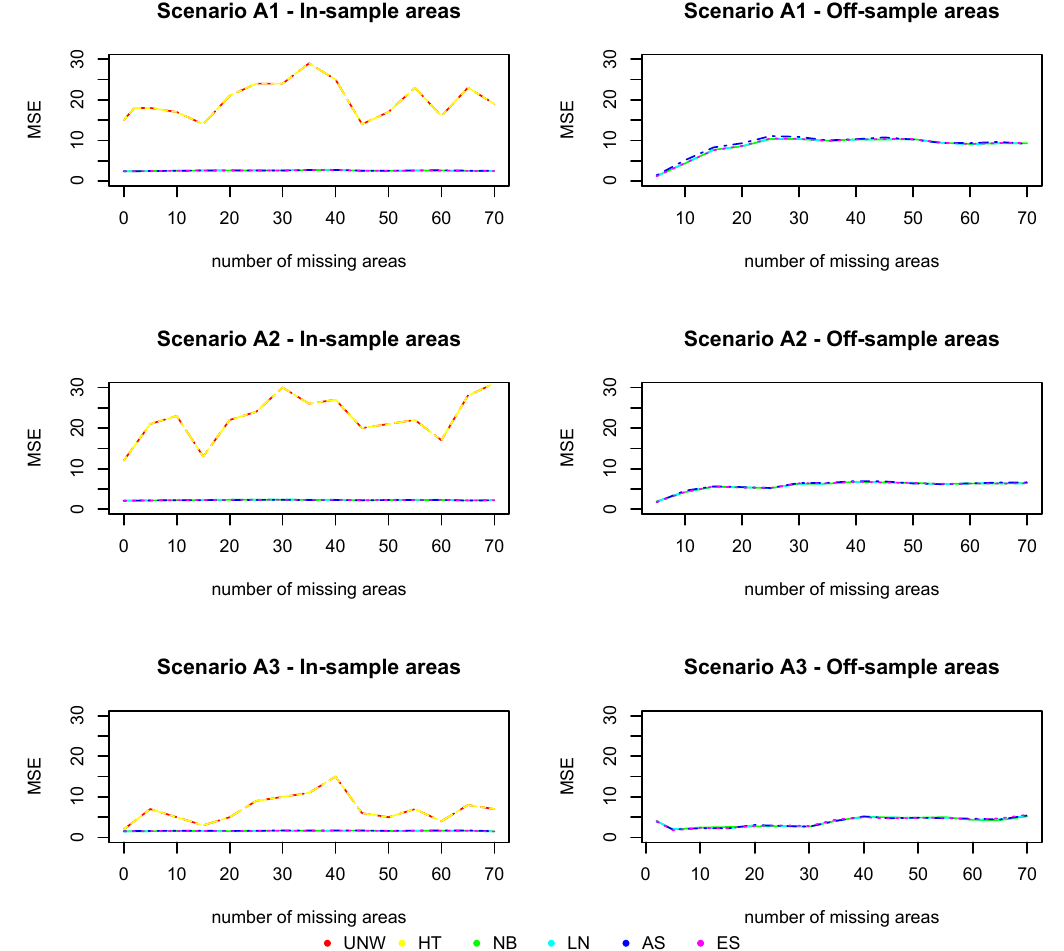
Figure 4. Simulation 1: Mean Squared Error ( × 10 3 ). UNW = unweighted estimator; HT = Horvitz–Thompson estimator; NB = naive binomial model; LN = logit-normal model; AS = arcsine model; ES = effective sample size model. ( A 1 ) : σ 2 v = 0.15 and σ 2 u = 0.03; ( A 2 ) : σ 2 v = 0.09 and σ 2 u = 0.09; ( A 3 ) : σ 2 = 0.03 and σ 2 = v u